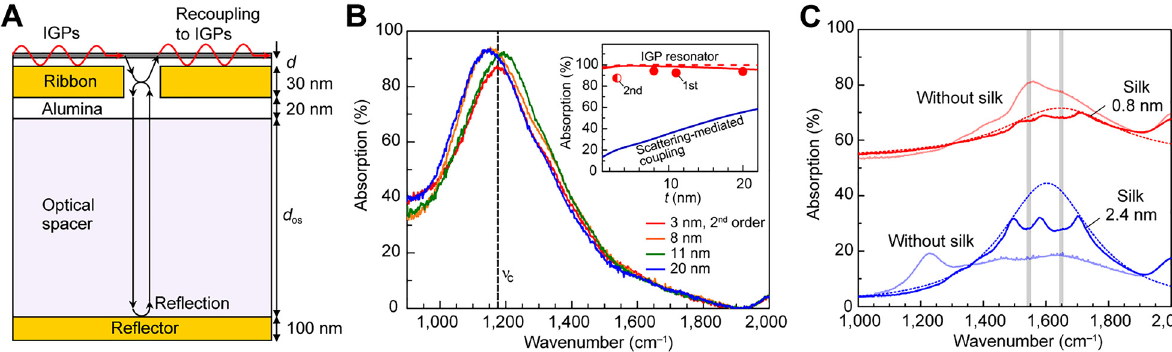
Figure 6: Molecular sensing with IGPs. (A)Imageplasmonresonatorwithgoldnanoribbonsembeddedinthealuminaandtheopticalcavity.(B)AbsorptionspectraoftheIGPresonator withdifferent aluminaspacer thicknesses andribbonwidths,providingphasematchingbetweentheoptical cavityandtheIGPresonanceinthe periodic structure. (C) Absorption spectra of the IGP resonator with (thick solid) and without (thick solid) a thin silk film; absorption lines of silk amides are clearly visible even for the 0.8 nm-thick fi lm. Adapted with permission from [55]. Copyright 2019, Springer